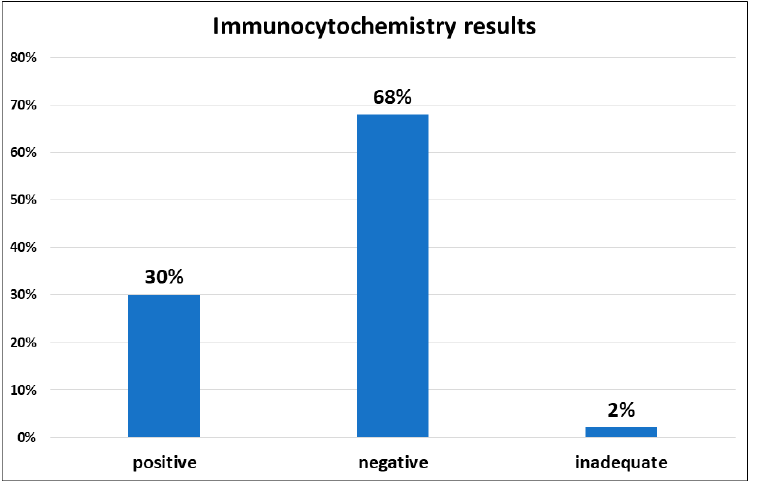
Figure 1. BRAF V600E mutation-specific adequacy. The immunocytochemistry resulted in adequate in 98%, and only 1 out of 50 (2%) cases resulted in inadequate. BRAF Immunocytochemistry resulted positive in 30% of the cases and negative in the remaining